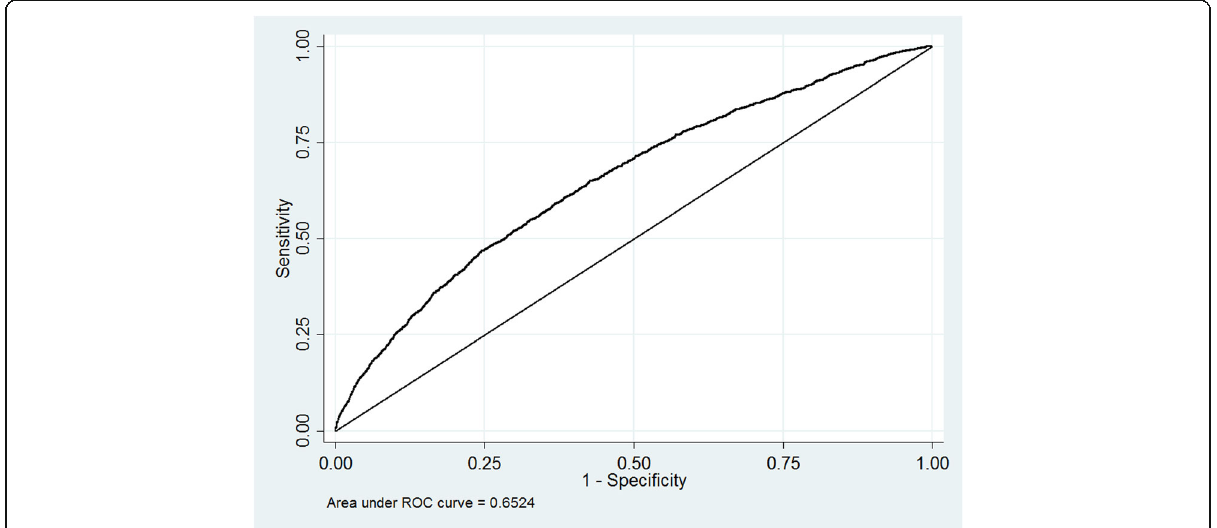
Fig. 1 ROC curve of model 2 for all